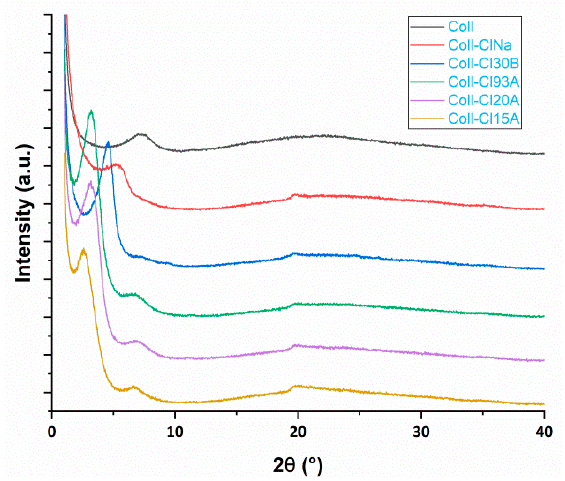
Figure 2. X-ray diffraction patterns of composite samples.